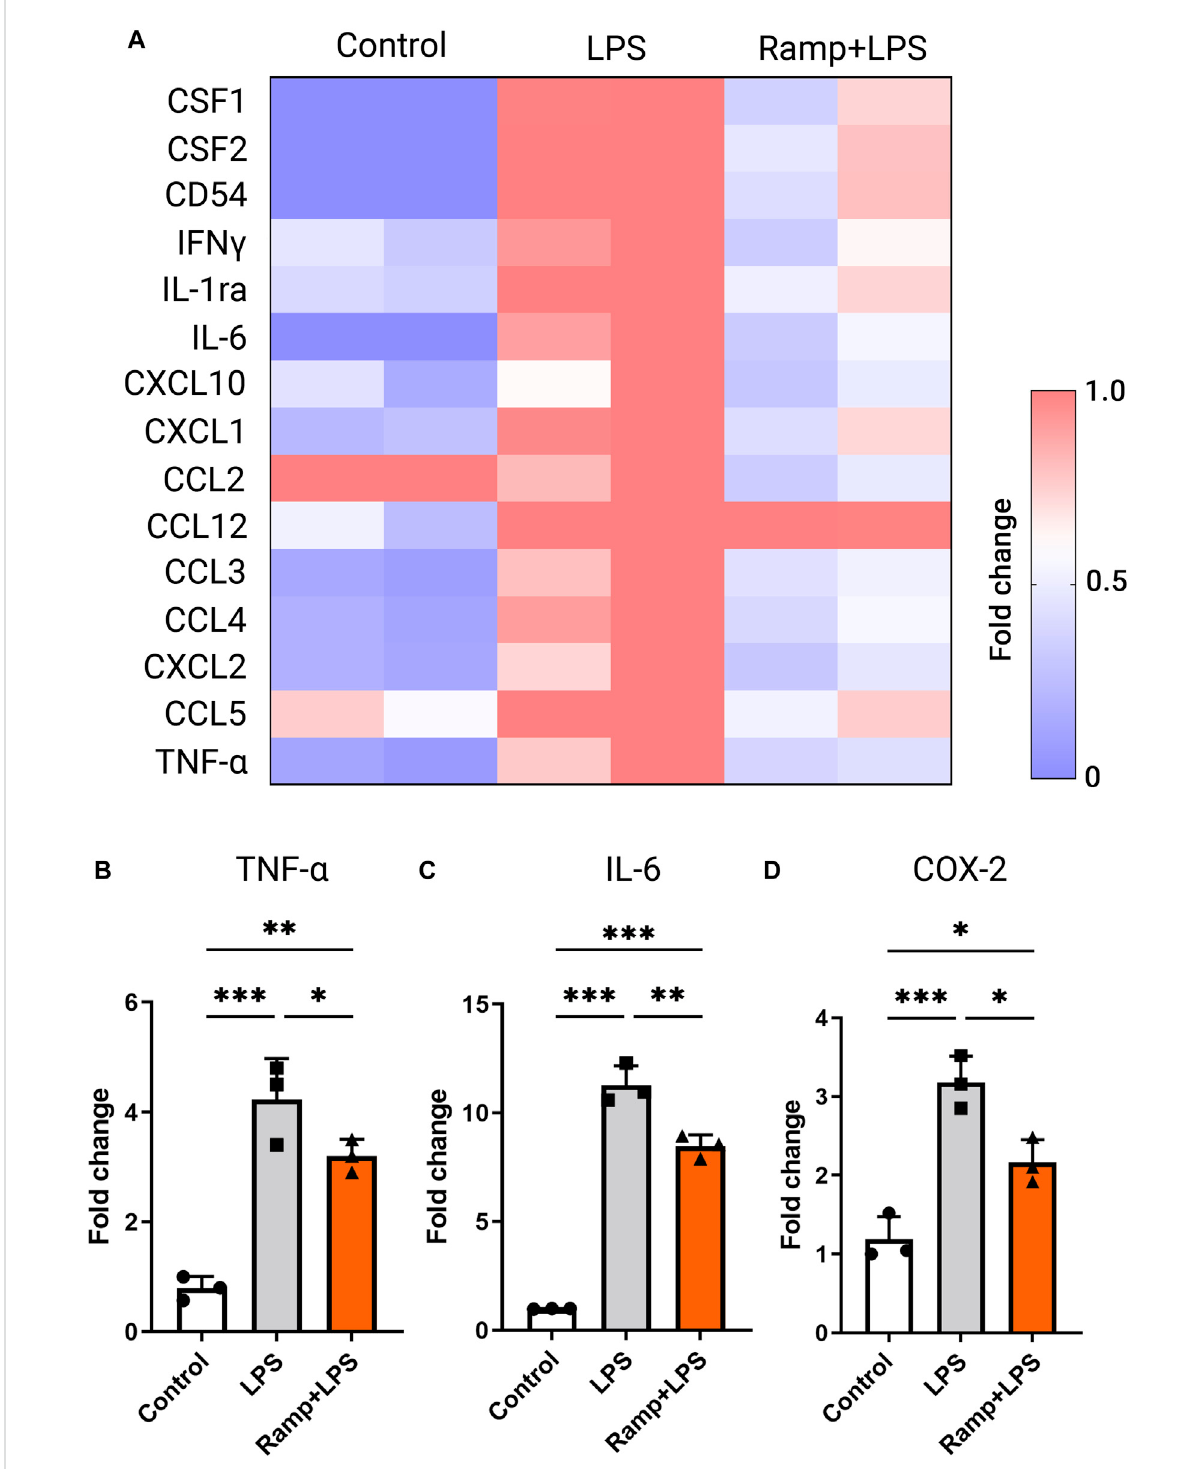
FIGURE 4 Electric stimulation with ramp waveform reduces BV-2 cell activation in response to LPS stimulation. (A) Heatmap of in fl ammatory cytokine levels as measured by values of densitometry of cytokine arrays and presented as fold changes normalized to the value of the LPS-stimulated group without the ES. RT-PCR (B – D) demonstrated changes in levels of expression of TNF- α (B) , IL-6 (C) , and COX-2 (D) in BV-2 cells subjected to ES biphasic ramp at 24 h after LPS stimulation. n = 3; Statistical signi fi cance was determined using one-way ANOVA with Tukey multiple comparisons. * p < 0.05; ** p < 0.01; value = means ±